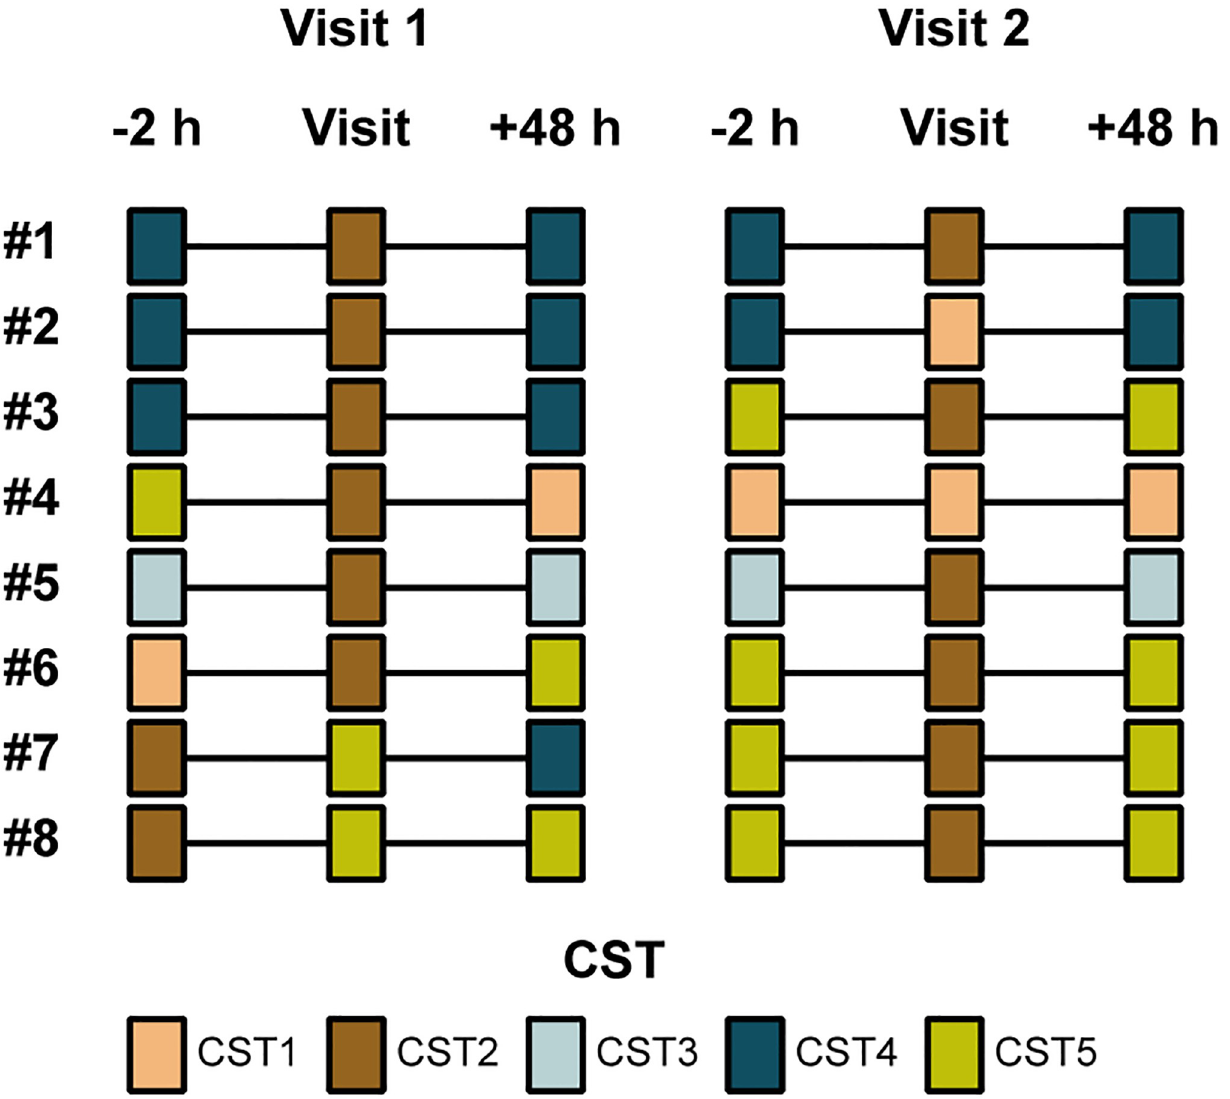
Fig 2. Bacterial community composition in short-term visitors. Community state types (CSTs) were determined in samples collected from volunteers two hours before, immediately after, and 48 hours after their two visits to a LA-MRSA CC398-positive pig farm.